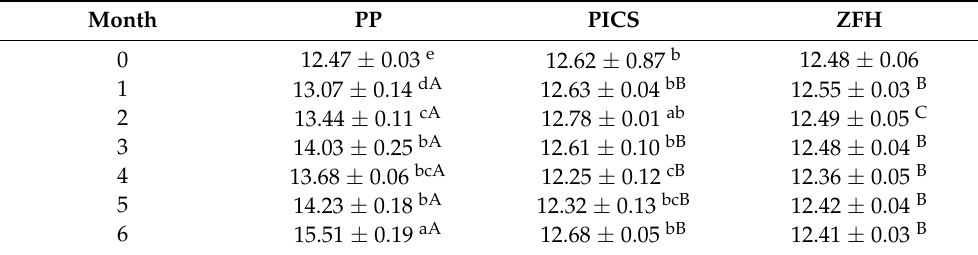
Table 1. Mean ( ± SE) percent moisture content (%MC) of maize in Polypropylene (PP), Purdue Improved Crop Storage (PICS), and ZeroFly ® Hermetic (ZFH) bags sampled during the months